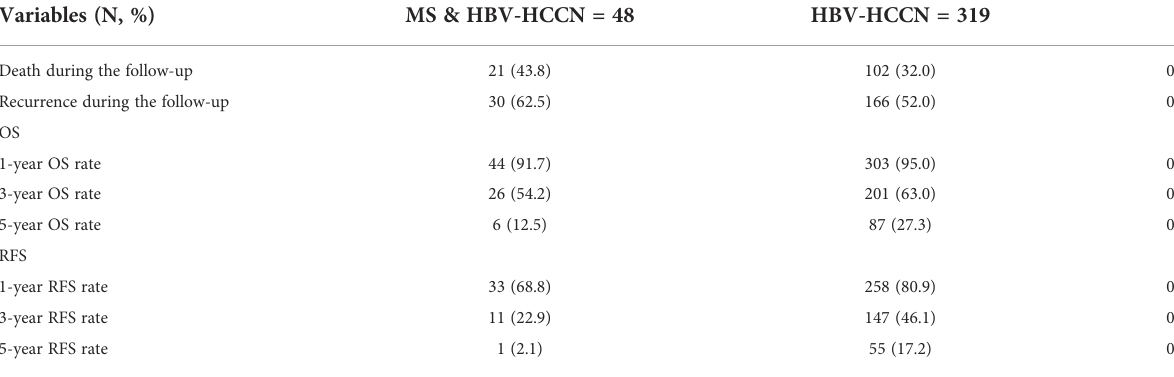
TABLE 2 Comparisons of long-term outcomes between HBV-infected patients with and without metabolic syndrome. Variables (N, %) Death during the